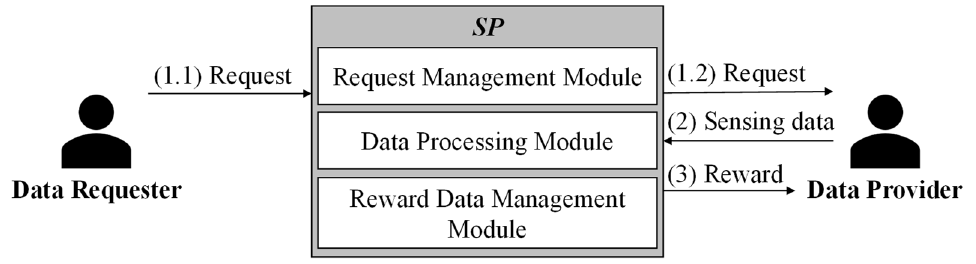
Figure 1. Structure of crowdsensing system.